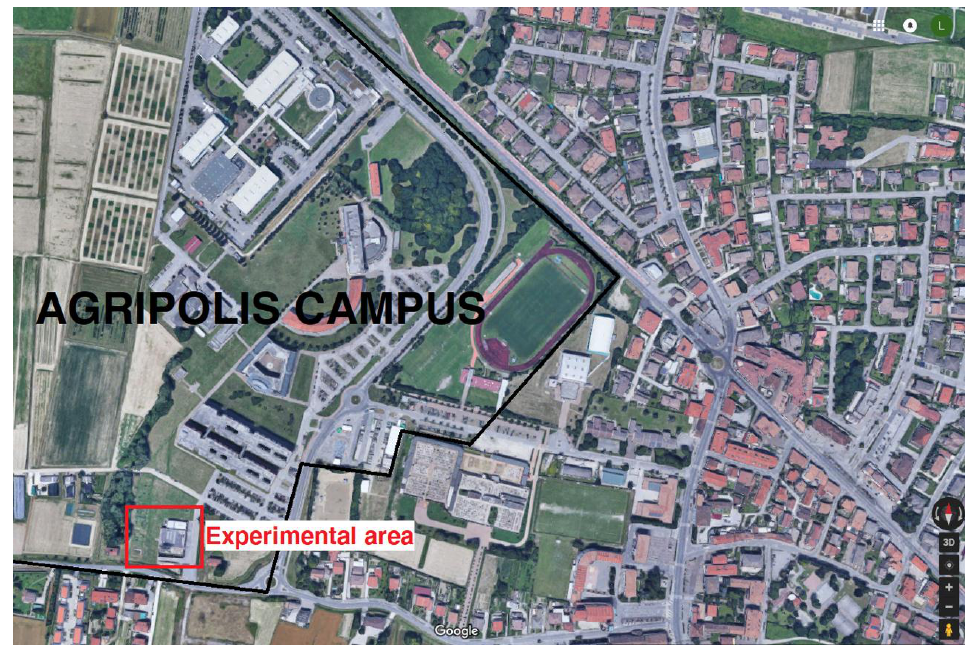
Figure 1. A Google Maps view of the Agripolis Campus of the University of Padova and the experimental area in which the two bioretention solutions (bioretention pond and rain garden system) are located.